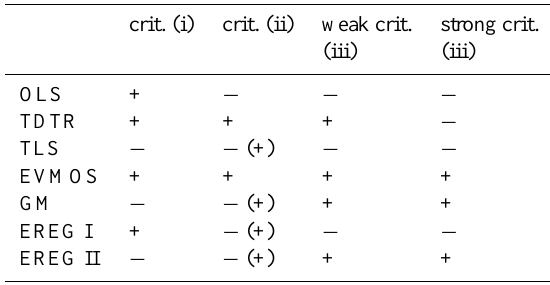
Table 1. Assessment of linear regression methods (rows) based on the criteria (columns) introduced in Sect. 2. A plus sign in brackets means that there exist methods to fulfil this criterion but they are not presented here.